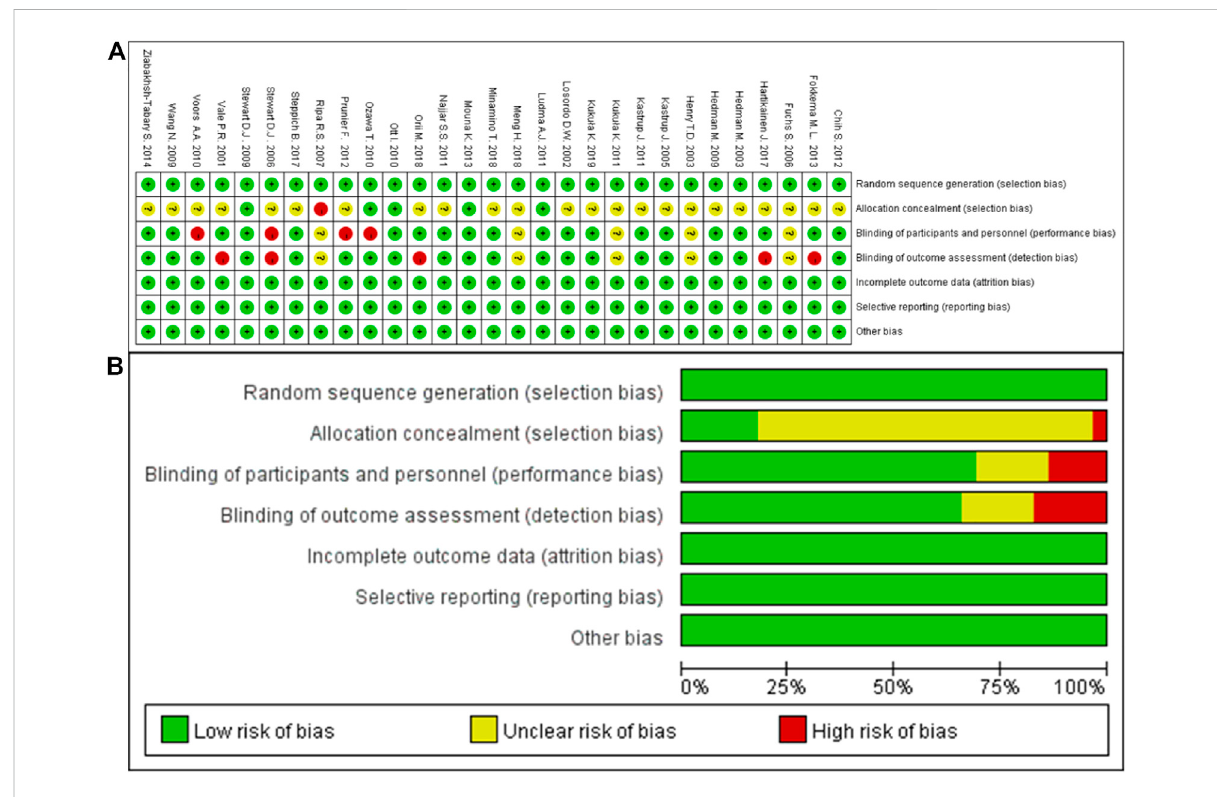
FIGURE 2 Risk of bias. (A) , Risk of bias summary: each risk of bias item for each included study; (B) , risk of bias graph: each risk of bias item presented as percentages across all included studies.